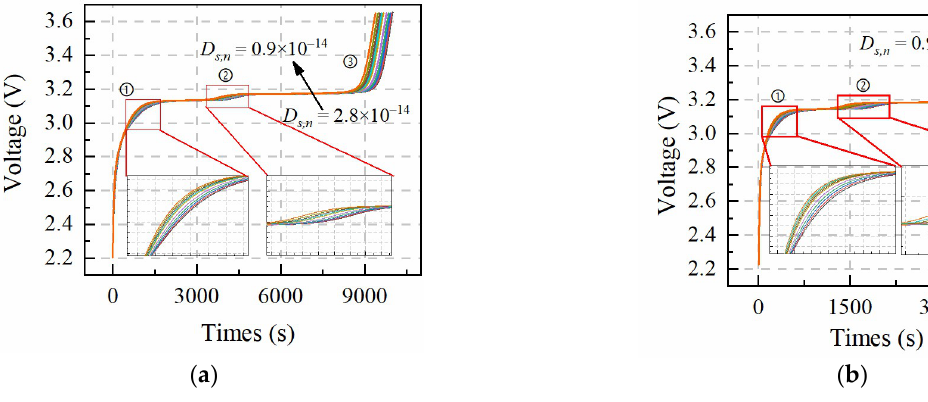
Figure 3. Sensitivity curves of battery terminal voltage to D s,n under different charging rates. ( a ) Sensitivity curves under 0.5 C charging rate; ( b ) Sensitivity curves under 1 C charging rate.